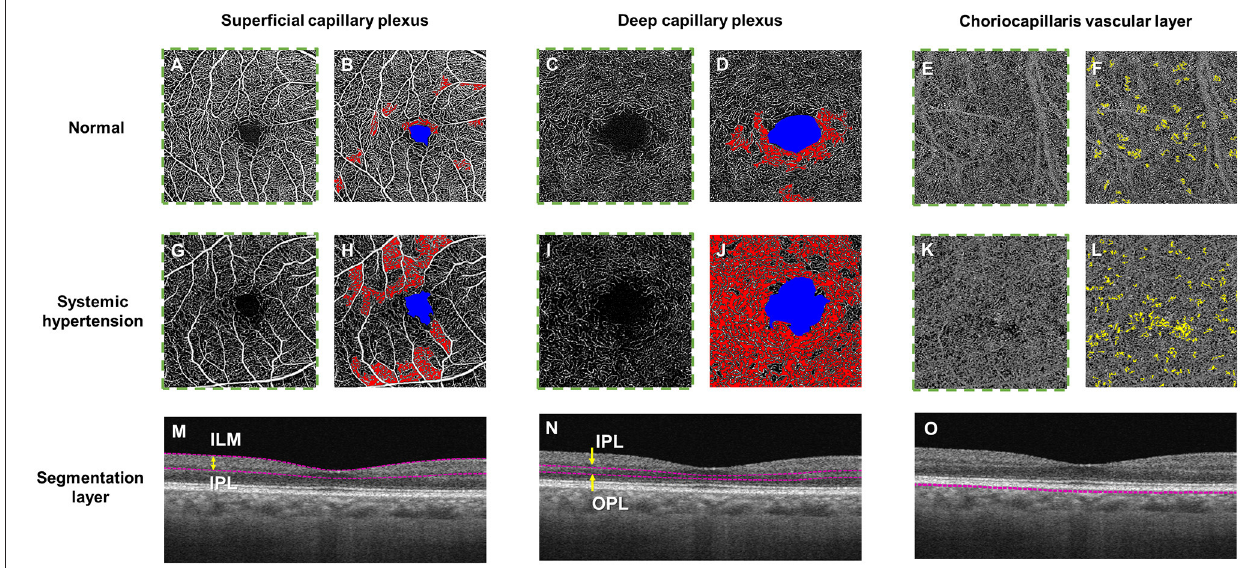
FIGURE 2 | Optical coherence tomography angiography (OCTA) and color-coded maps of a healthy control individual (Top panel; A–F ) and a hypertensive individual with poorly controlled blood pressure (Middle panel; G–L ) and the horizontal B-scan images of the corresponding layer (Bottom row, M–O ). OCTA metrics, including fovea avascular zone (FAZ) area (in blue), retinal vessel density and choriocapillaris flow void deficits, can be calculated automatically. (M) The superficial plexus was segmented from the internal limiting membrane (ILM) to the inner plexiform layer (IPL), (N) the deep plexus was segmented from the IPL to the outer plexiform layer (OPL) and the choriocapillaris layer was segmented within a thin 10 µ m thick slab (31–40 µ m) below the retinal pigmented epithelium. The presence of larger non-perfusion area (in red) can be detected in both the superficial and deep capillary plexuses and more choriocapillaris flow voids (in yellow) in a hypertensive eye (H, J, L) as compared to the healthy eye (B, D, F)